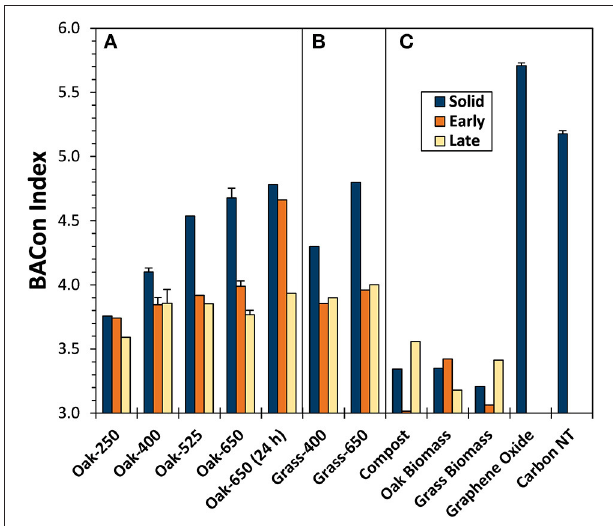
FIGURE 4 | BPCA aromatic condensation (BACon) index values for biochar solids and “Early” and “Late” leachates of (A) oak char thermal series, (B) grass chars, and (C) reference